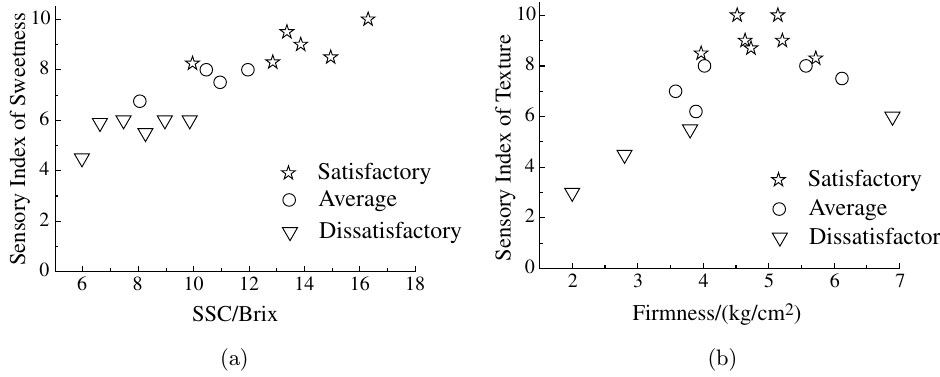
Fig. 2. The correlation of melon sensory index of (a) sweetness and (b) texture with